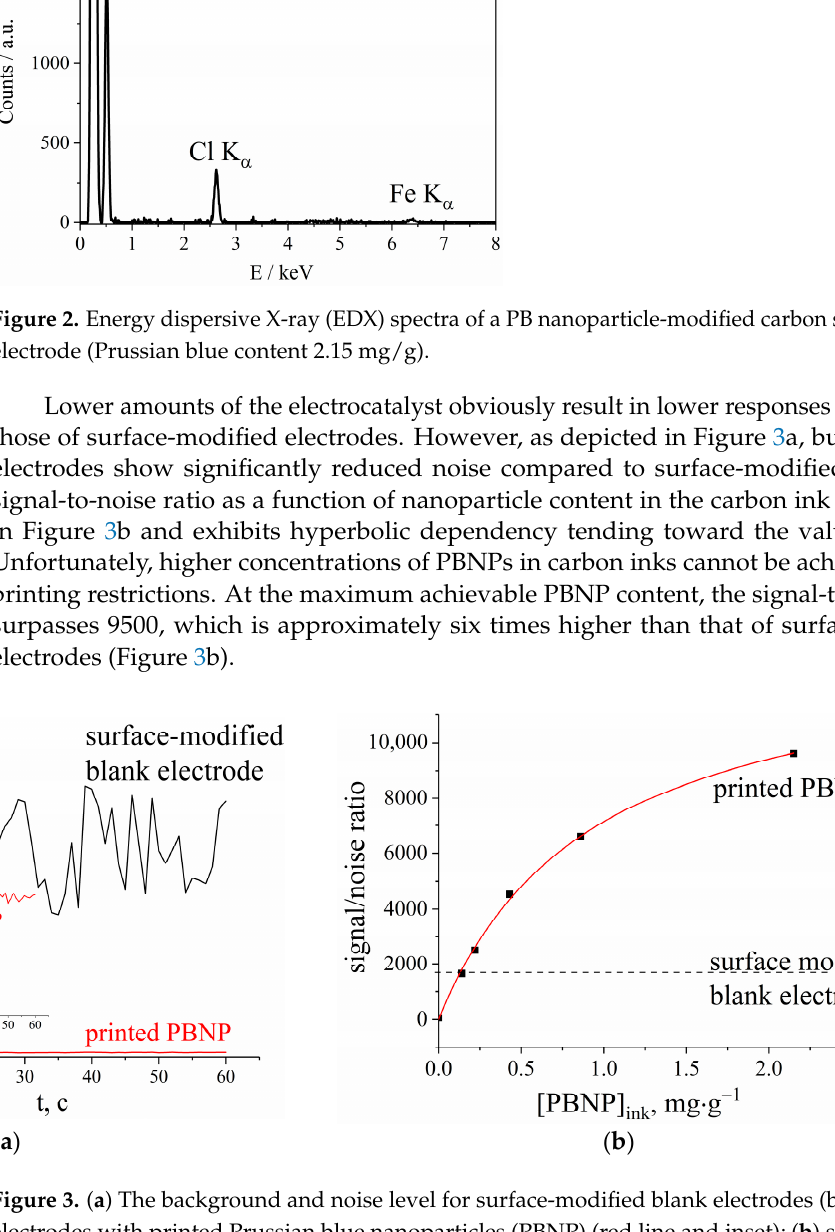
Figure 1. The example of hydrodynamic size distribution obtained by dynamic light scattering and fit to the log-normal distribution for Prussian Blue nanoparticles with the average diameter of 35 nm.